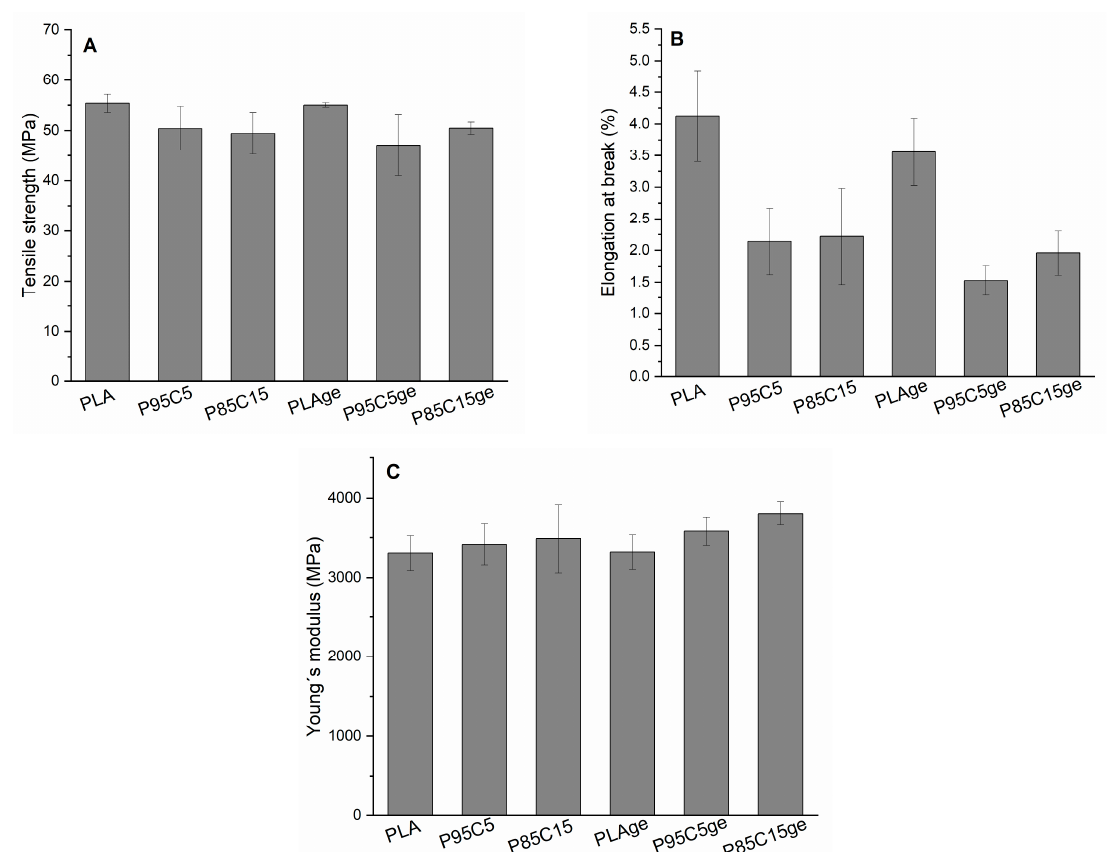
Figure 3. Mechanical properties of PLA and blends measured by tensile tests. In ( A ), tensile strength; in ( B ), elongation at break; in ( C ), Young´s modulus results.